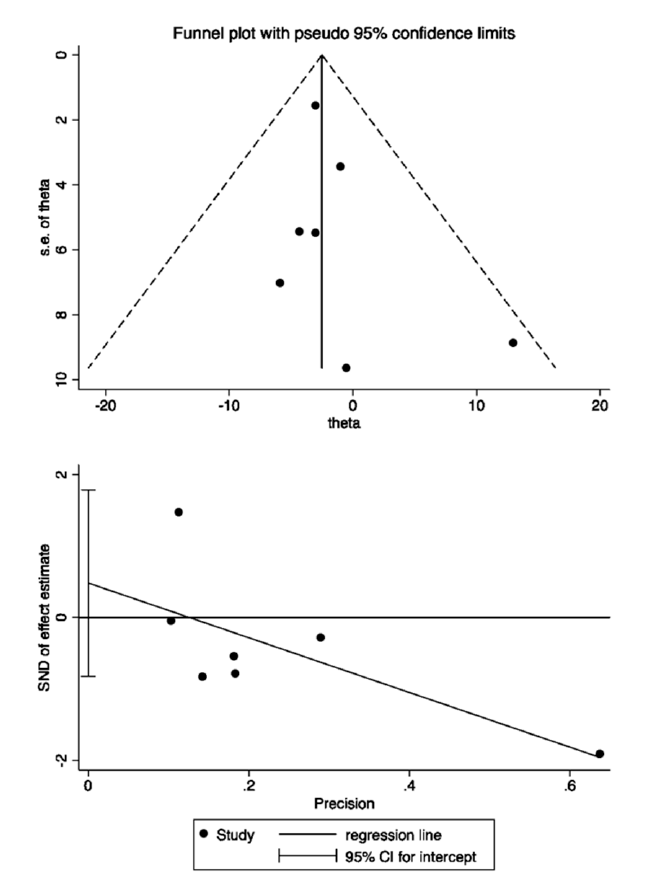
Figure 4. Assessment for publication bias by Funnel plot and Egger test.